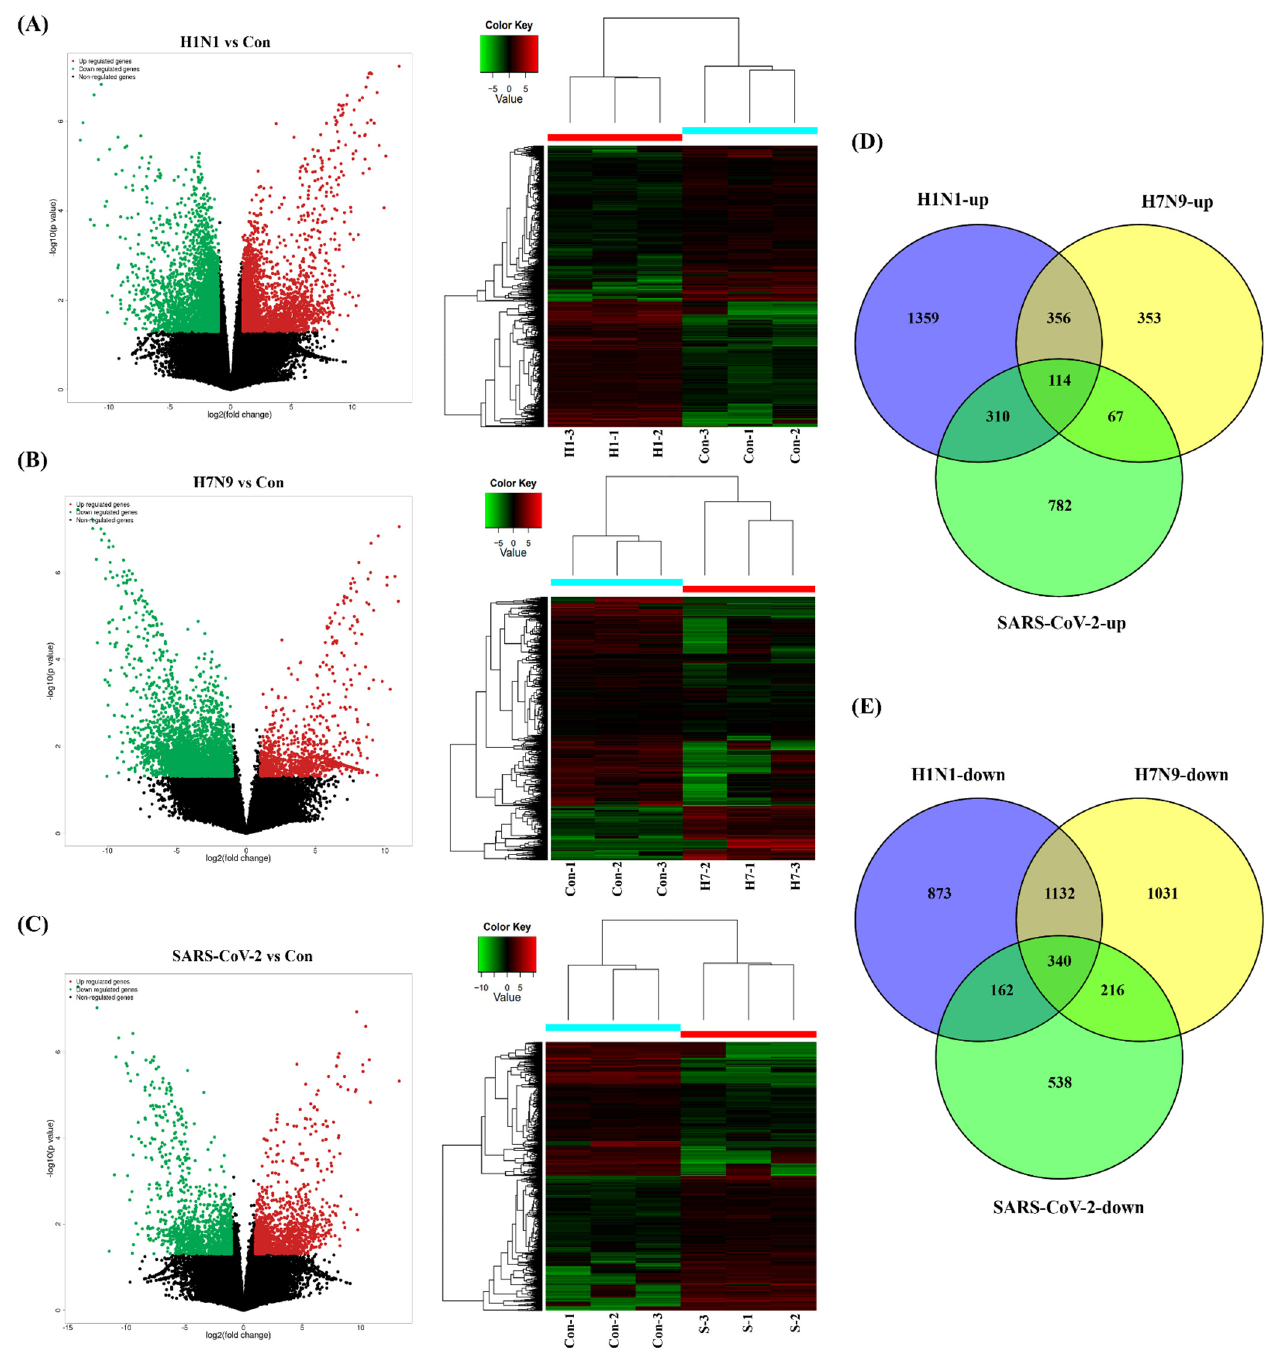
Figure 1. Clustering analysis of viral infections and control based on mRNA RNA-seq. ( A – C ) Volcano plots and heatmaps of differentially expressed genes (DEGs) after SARS-CoV-2, panH1N1, and H7N9 invaded. “H1-1-3” represents the H1N1 infection group with 3 replications, “H7-1-3” represents the H7N9 infection group with 3 replications, “S-1-3” represents the SARS-CoV-2 infection group with 3 replications. ( D , E ) A Venn analysis of all the upregulated and downregulated mRNAs among the three groups, respectively.